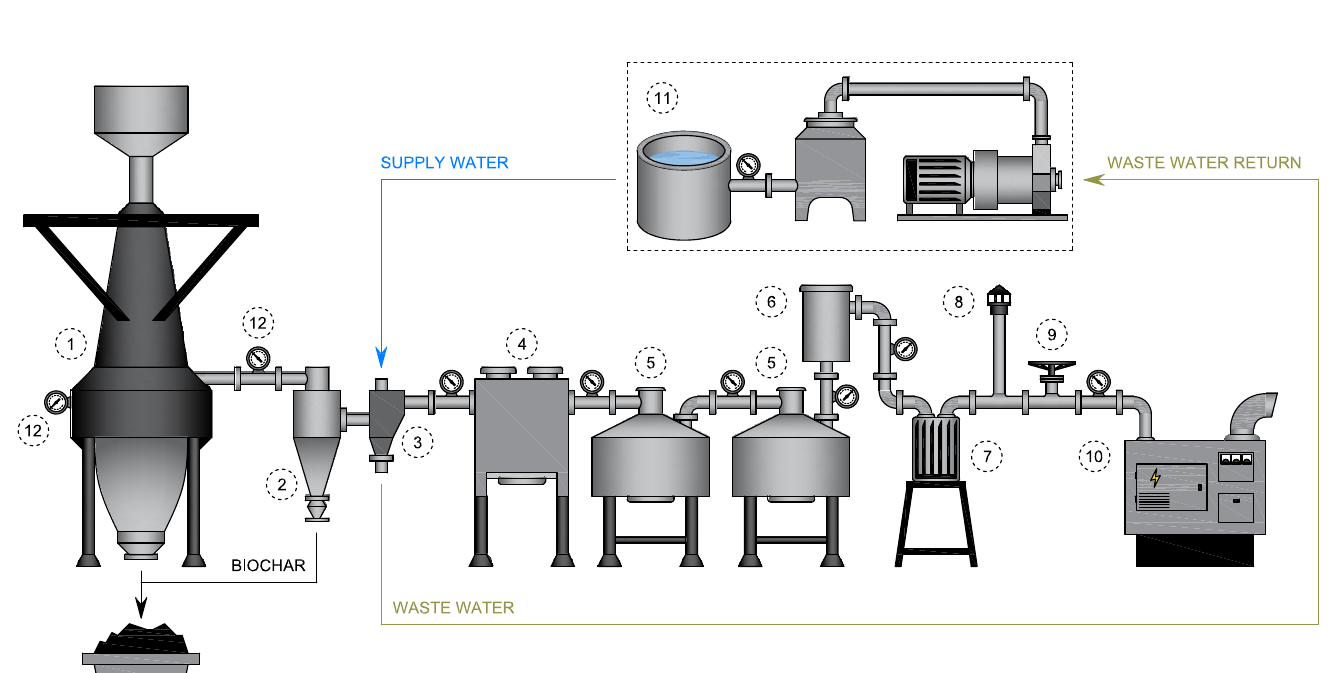
Figure 3. Layout of the gasification plant. (1) Downdraft fixed bed gasifier; (2) cyclone; (3) Venturi scrubber; (4) moisture and particle filter; (5) fine filters; (6) safety filter; (7) air blower; (8) flare stack; (9) engine feed valve; (10) spark-ignition engine–generator set; (11) waste water treatment unit; (12) pressure and temperature